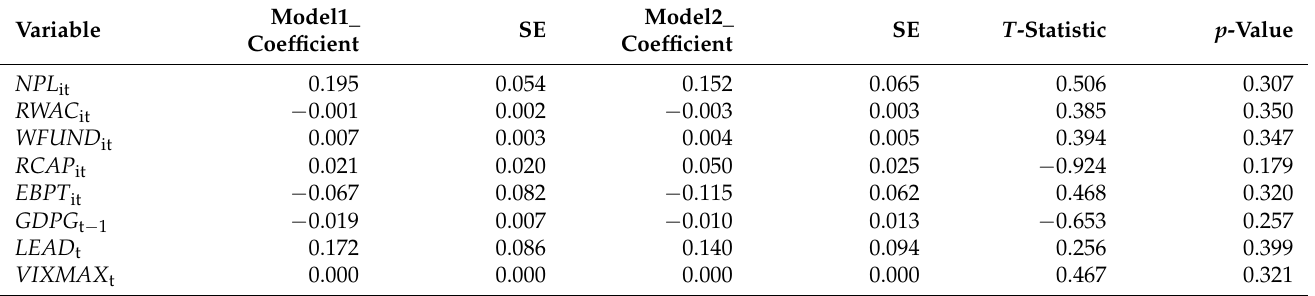
Table A2. Comparison of crisis (3) and crisis (adjusted)